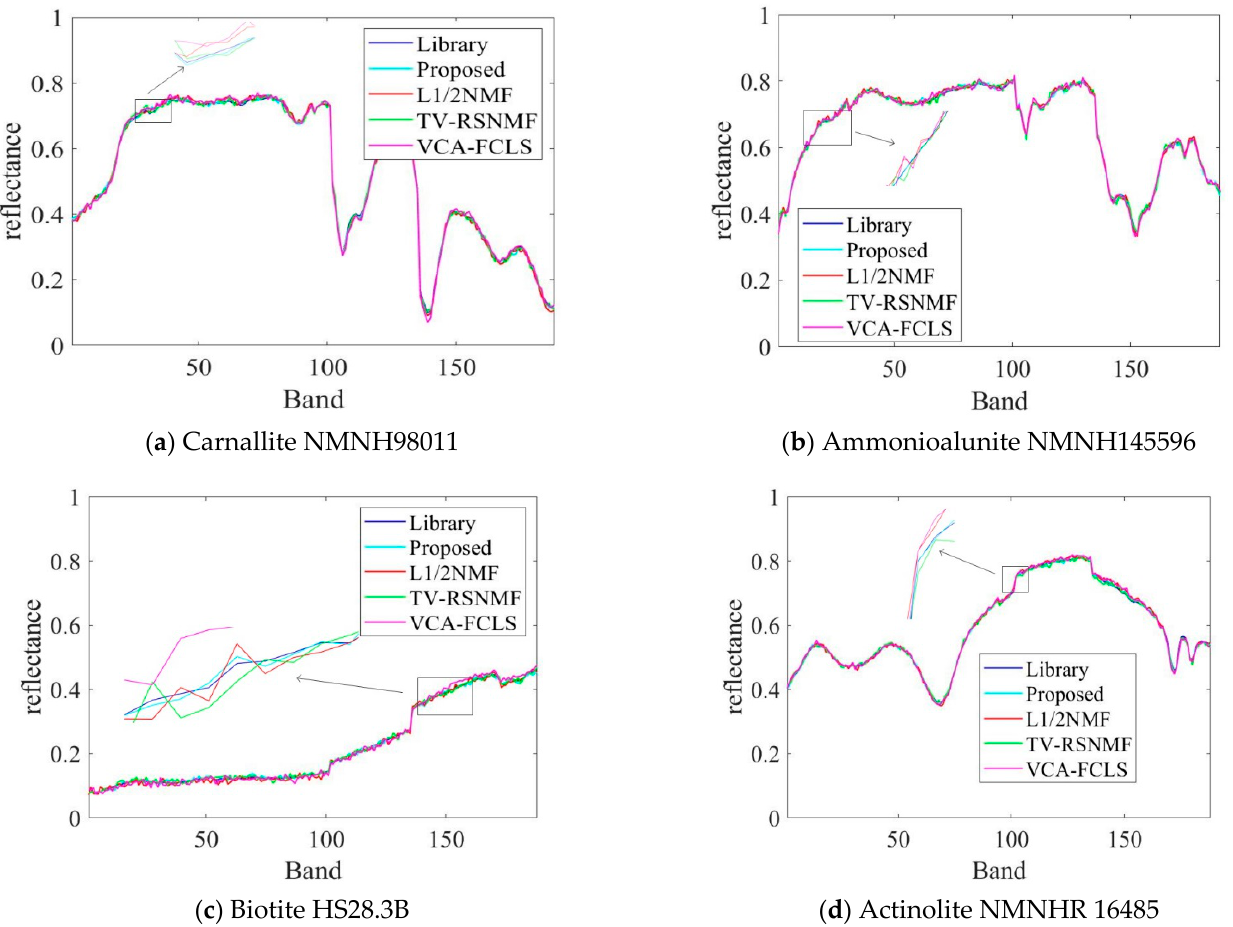
Figure 6. Comparison of the end-member signatures extracted by the SSC-NMF method with the reference spectra.